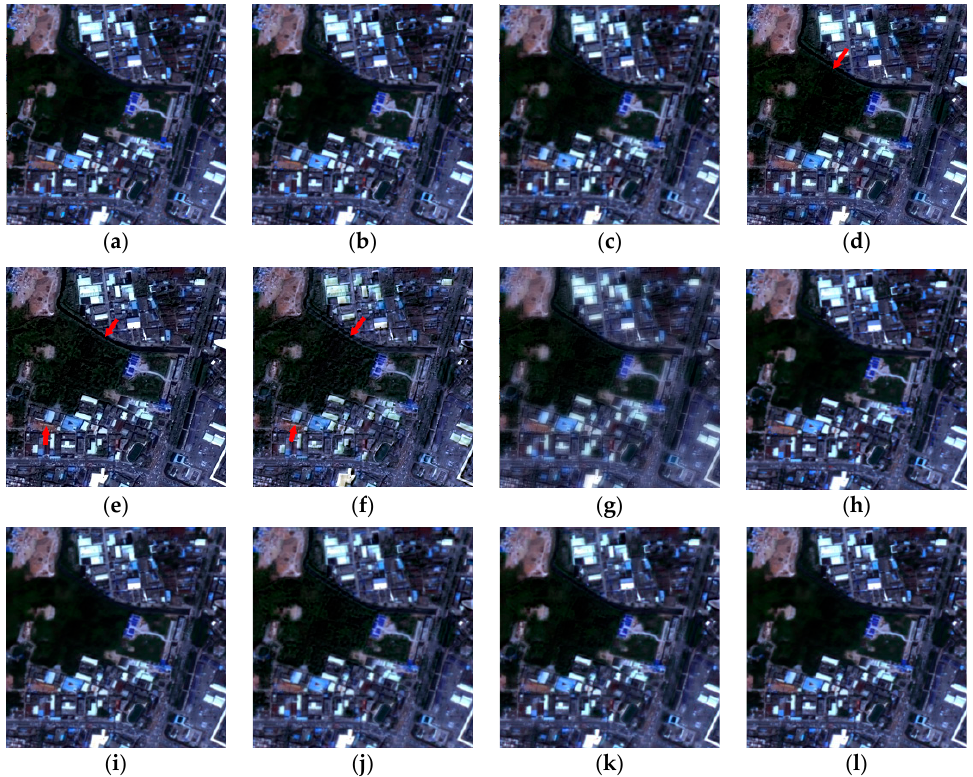
Figure 5. Fused images of different methods on GaoFen-2 dataset. ( a ) ground truth; ( b ) our model; ( c ) PNN; ( d ) BDSD; ( e ) GSA; ( f ) Indusion; ( g ) ATWT-M3; ( h ) TFNet; ( i ) PNN+; ( j ) DRPNN; ( k ) PanNet; and ( l ) MSDCNN.